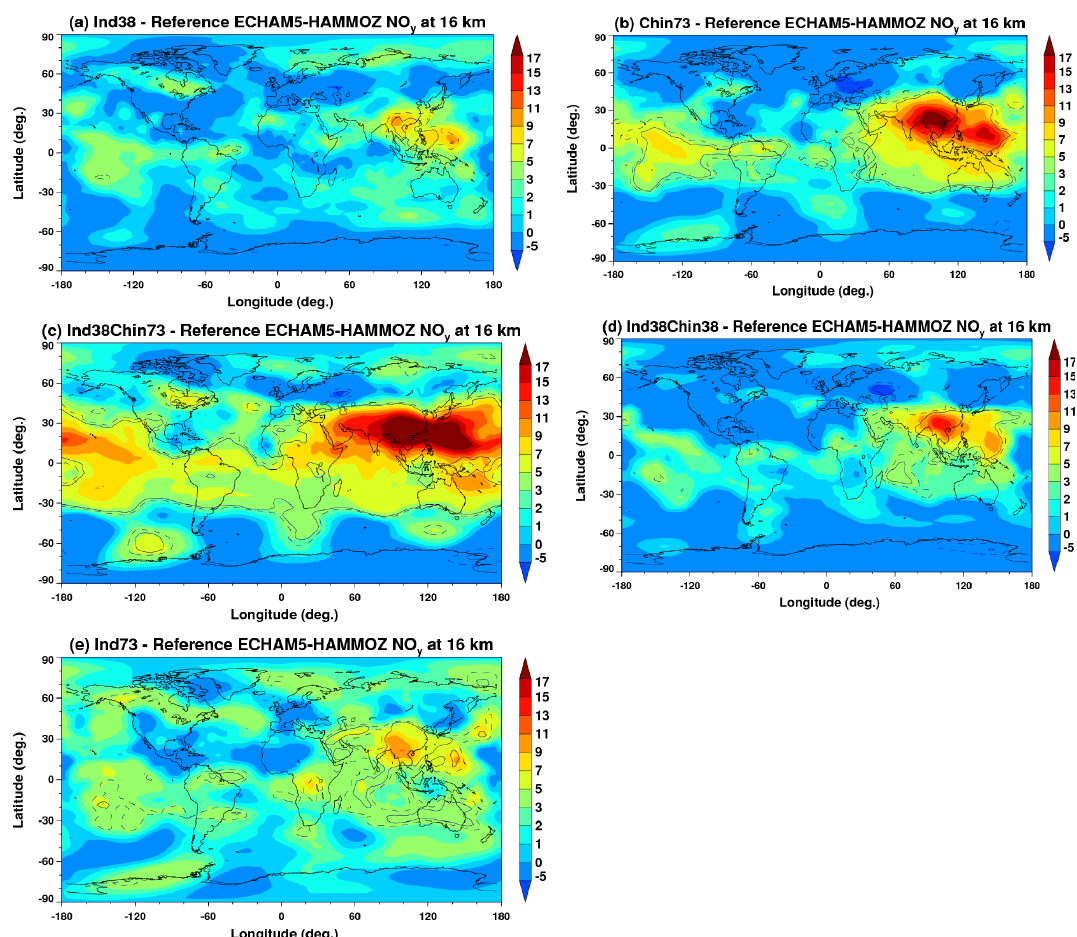
Figure 8. Percentage change in ECHAM5-HAMMOZ NO y (NO + NO 2 + NO 3 + 2 · N 2 O 5 + HNO 3 + HNO 4 + PAN + MPAN + ONIT + ONITR + ISOPNO 3 ) at 16km, as obtained from (a) Ind38, (b) Chin73, (c) Ind38Chin73, (d) Ind38Chin38, and (e) Ind73 simulations. Solid black line indicates the 95% Student’s t test confidence interval while the dashed line indicates 90% confidence